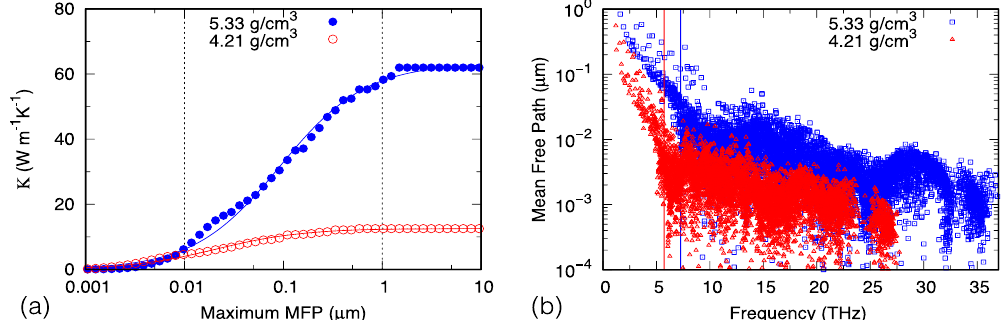
Figure 2. ( a ) Cumulative κ with respect to phonon mean free path at 300 K, ( b ) Mean free path versus phonon frequency at 300 K. Vertical lines in ( b ) correspond to frequencies of acoustic phonons at Brillouin zone boundary ≡ ( ) X 00 1 . Phonons reside on the left (right) side of the lines are predominately acoustic (optical). 2 The corresponding pressures at ρ = 4.21 g/cm 3 and 5.33 g/cm 3 are 3.9 GPa and 104.9 GPa,